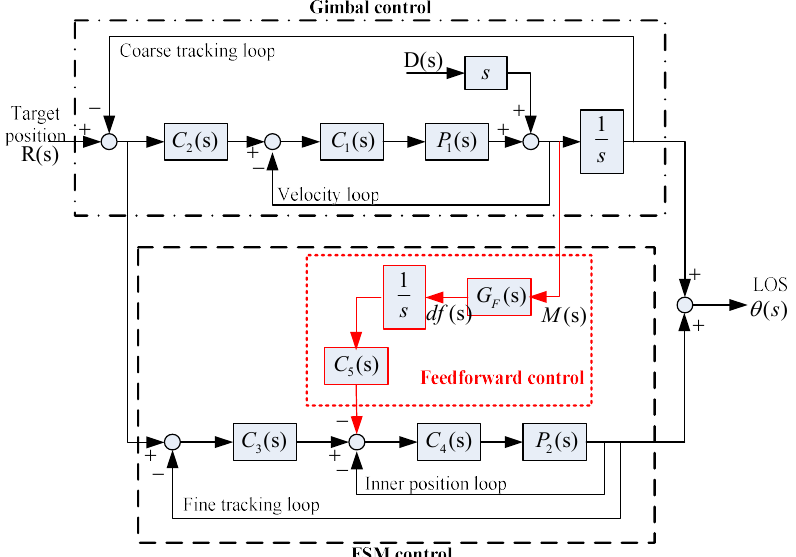
Figure 2. Control structure with feedforward control (CS-FC) for EOTS. P 1 ( s ) is the equivalent velocity control object of gimbal, it may include acceleration loop and current loop; P 2 ( s ) is the position control object of fast steering mirror(FSM); C 1 ( s ) is the gimbal velocity loop controller; C 2 ( s ) is the gimbal tracking loop controller; C 3 ( s ) is the FSM tracking loop controller; C 4 ( s ) is the FSM inner position loop controller; C 5 ( s ) is the feedforward controller; G F ( s ) is the filter; D ( s ) is the disturbance angle; R ( s ) is the target position; θ ( s ) is the line-of-sight (LOS)